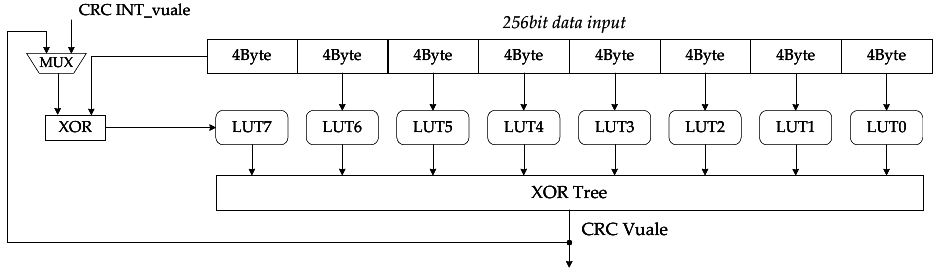
Figure 9. CRC module architecture for 256bits parallel